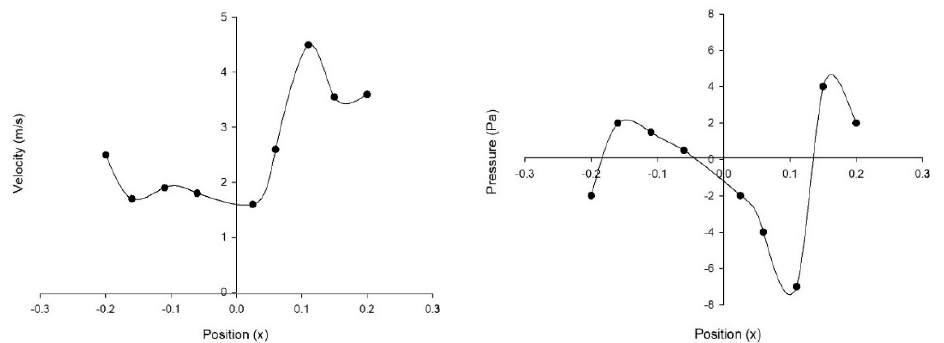
Figure 15. Pressure and velocity distribution across the distribution line.